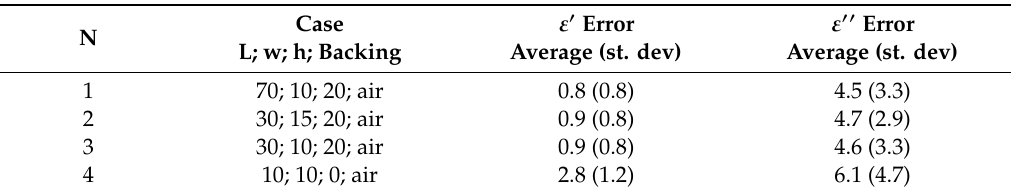
Table 4. Average errors achieved in the evaluation of the real and imaginary part of the relative complex permittivity of fat when the MUT has one boundary at 10 mm from the